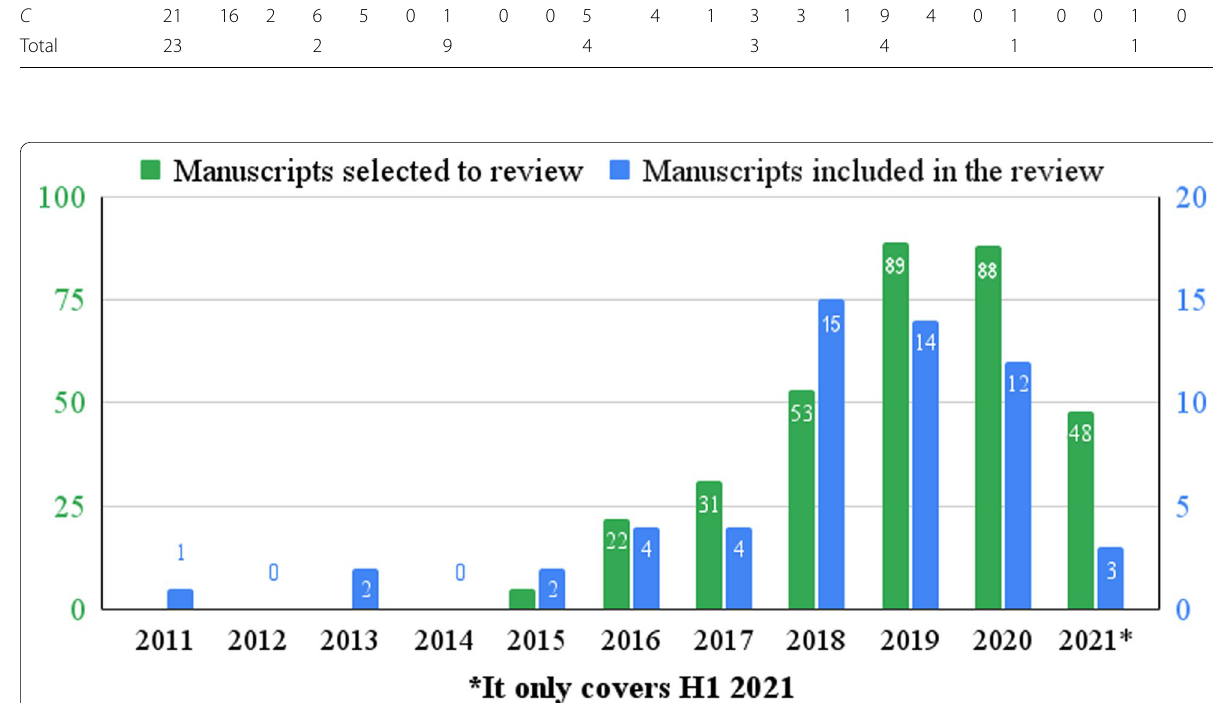
Fig. 3 Number of initially selected references (green) and actually included ones (blue) in the review per